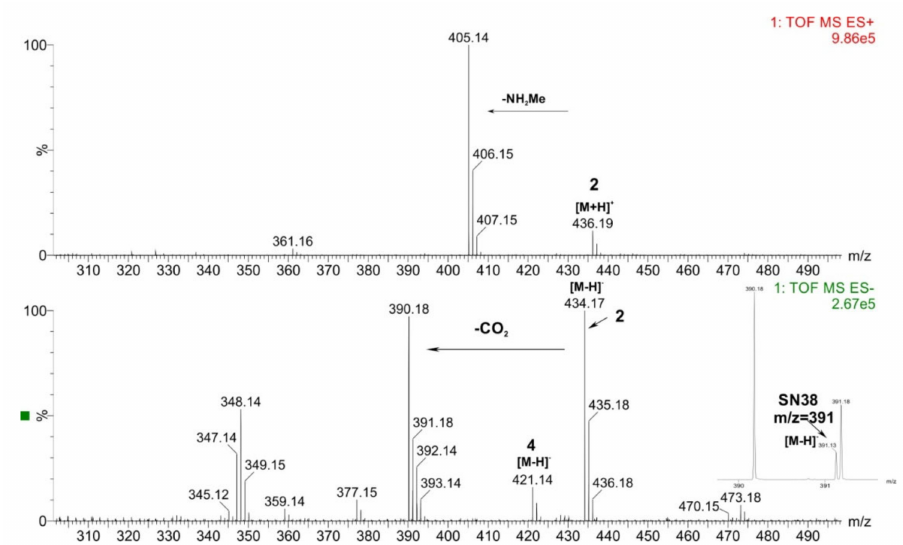
Figure 4. The ESI–MS spectrum (in the m/z range 300–500) of positive (upper trace) and negative ions (lower trace) of mother liquor of reaction 1 with 2